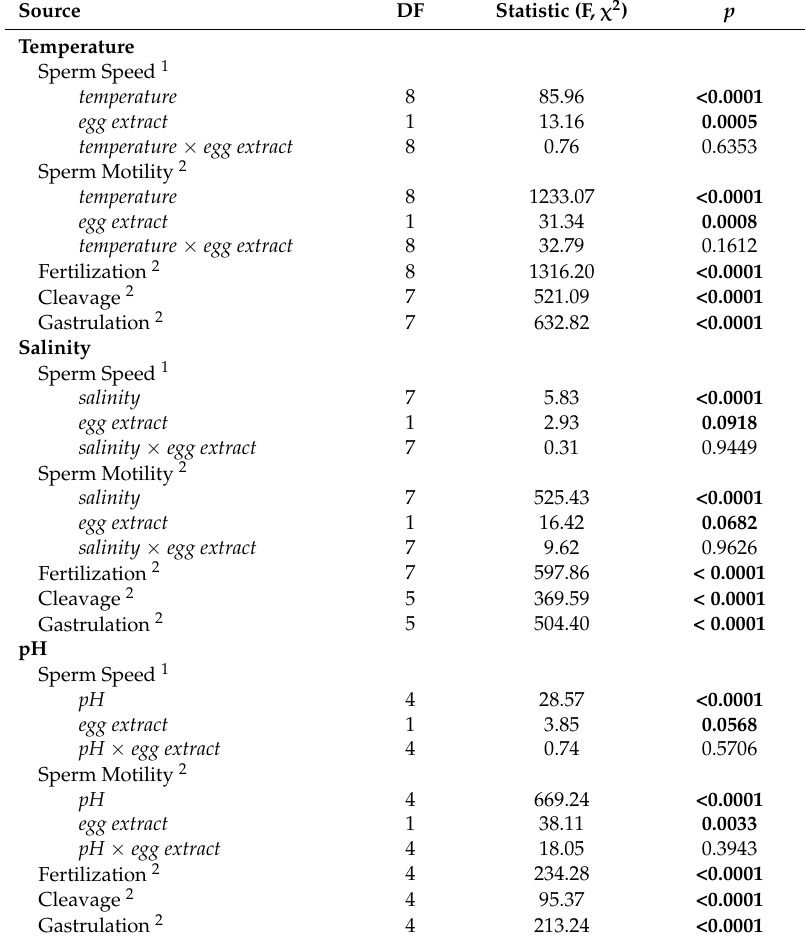
Table A1. Results of statistical analyses on the effects of temperature, salinity, and pH on sperm behavior, fertilization, and early